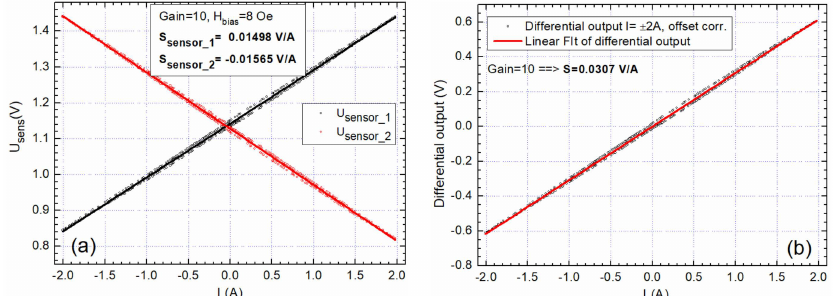
Figure 14. Di ff erential output of sensors polarized at 8 Oe, DC ± 2 A: ( a ) individual sensors response; ( b ) di ff erential